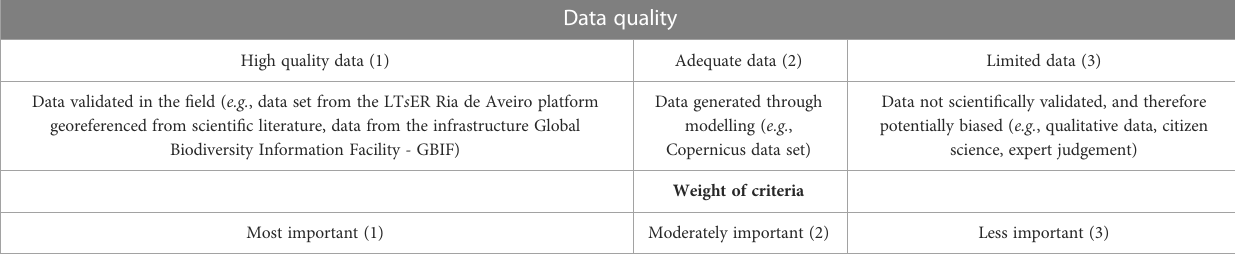
TABLE 3 Data quality and criteria weight scores. The data quality scores varied based on the source of